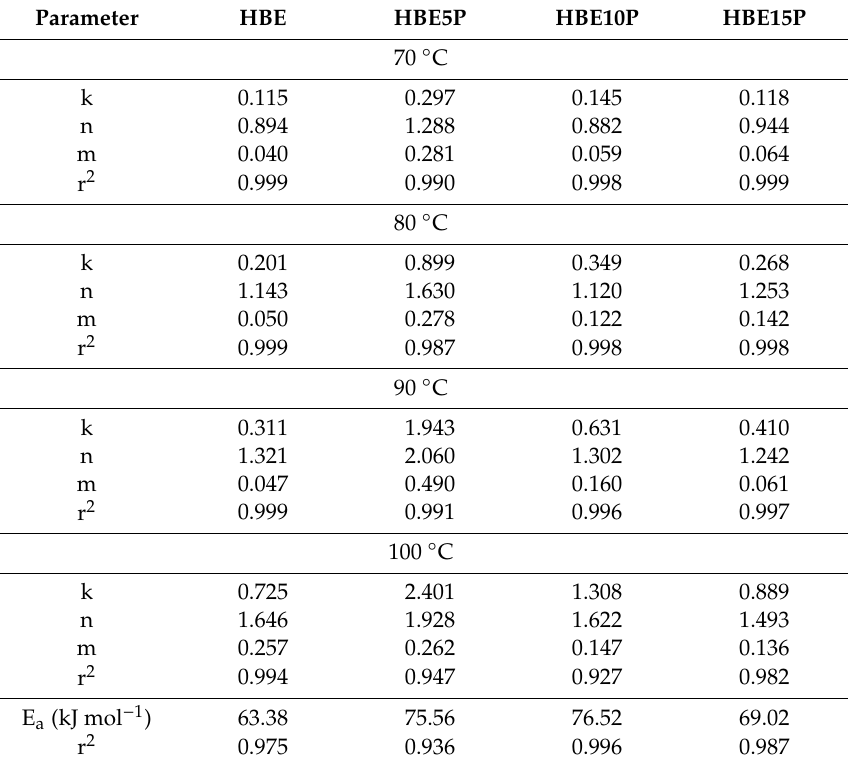
Table 4. The curing kinetic parameters of the hyperbranched epoxy at several curing temperatures. Parameter